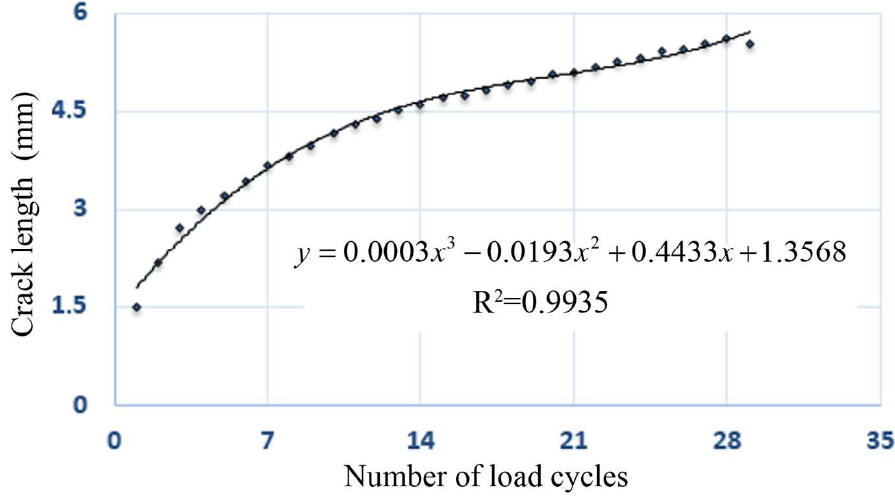
Figure 10. The relationship between crack length and the number of load cycles. Based on the above relationship between crack length and the number of load cycles, the expression dc can be obtained. The relationship between SIF and crack change rate dc dN can be calculated, as shown in Figure